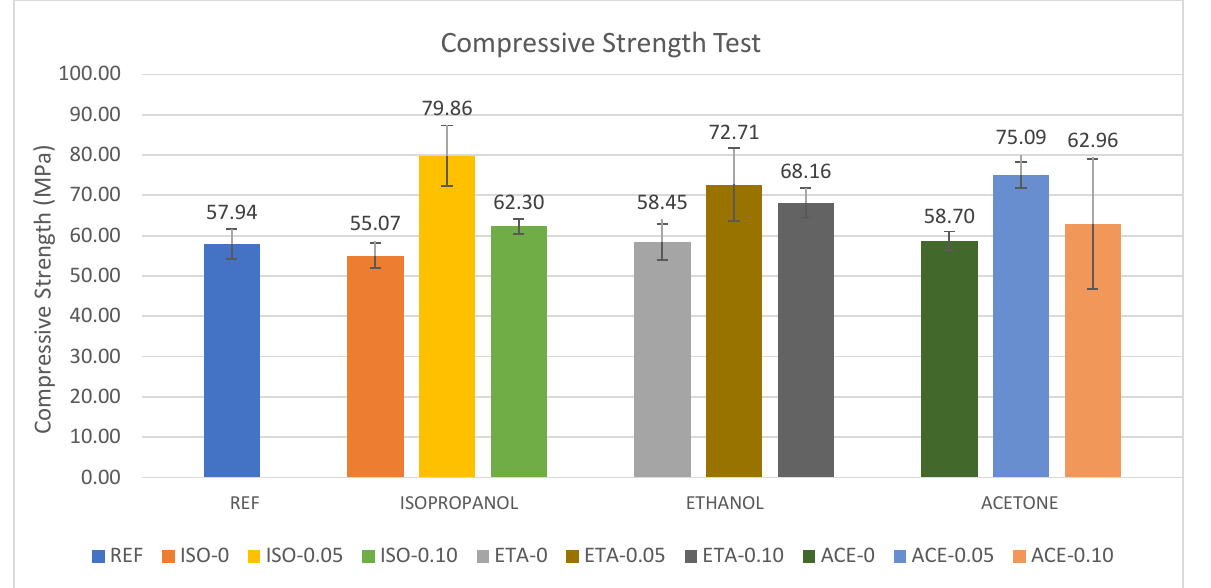
Figure 7. Results of the compressive strength tests. Comparing the mixtures REF, ACE-0, ETA-0, and ISO-0 with the reference, a small variation in the compressive strength results was observed, which is shown in the girth column of Table 5. The null hypothesis that the means of the mixtures are different could not be rejected, which means there is no significant variation in the means caused by the dispersion media. Table 5. Splitting tensile strength test results.